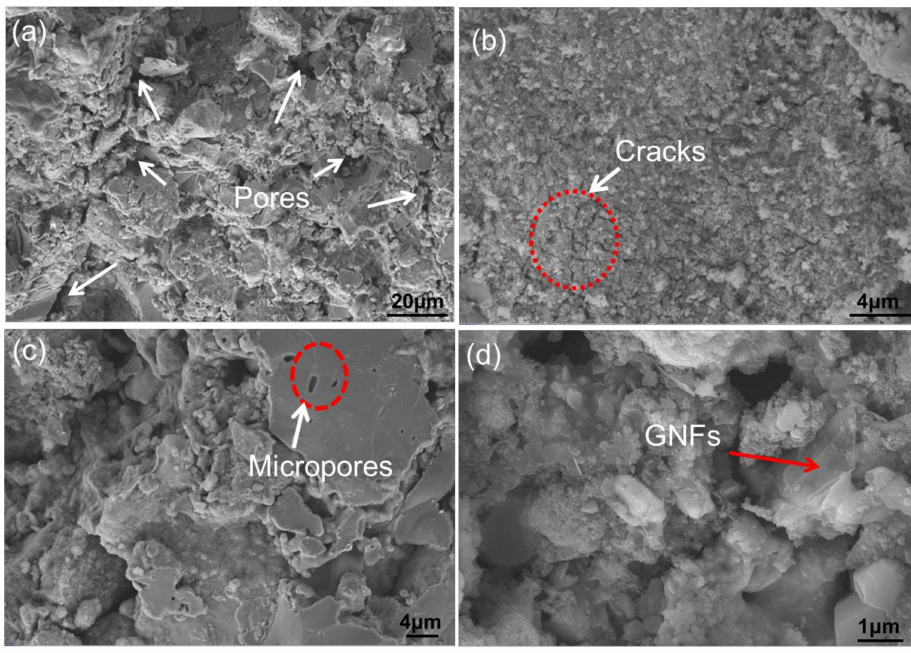
Figure 12. SEM micrographs of shear fracture surfaces of ( a , b ) the 0.5-GNFs nanocomposites in different regions; ( c ) the 1.0-GNFs nanocomposites; and ( d ) the 1.5-GNFs nanocomposites,